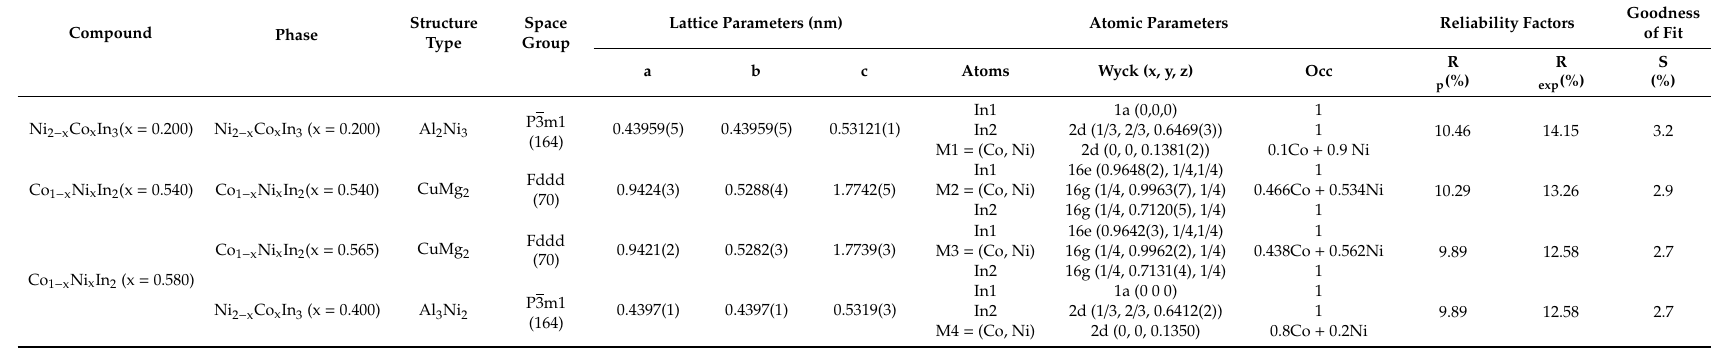
Table 4. Crystallographic data and Rietveld refinement results for Ni 2 − x Co x In 3 (x = 0.200) and Co 1 − x Ni x In 2 (x = 0.54, 0.58)